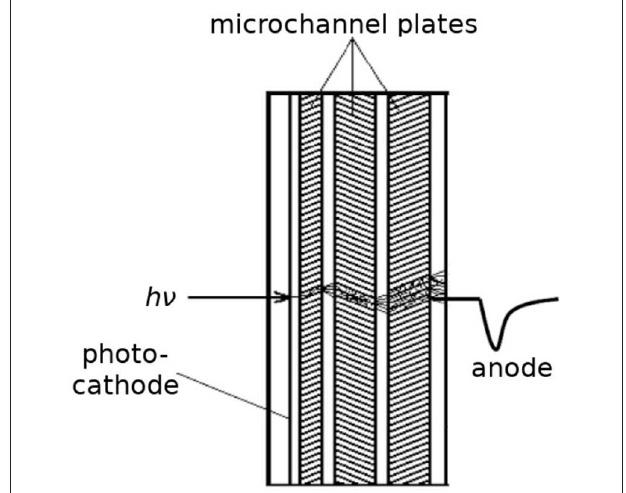
FIGURE 5 | Schematic of a microchannel plate. A photon impinging on the photocathode can liberate a photoelectron, which is attracted into the first microchannel plate where secondary emission inside the microchannels produces more electrons. They can be converted into a timing pulse at the anode.